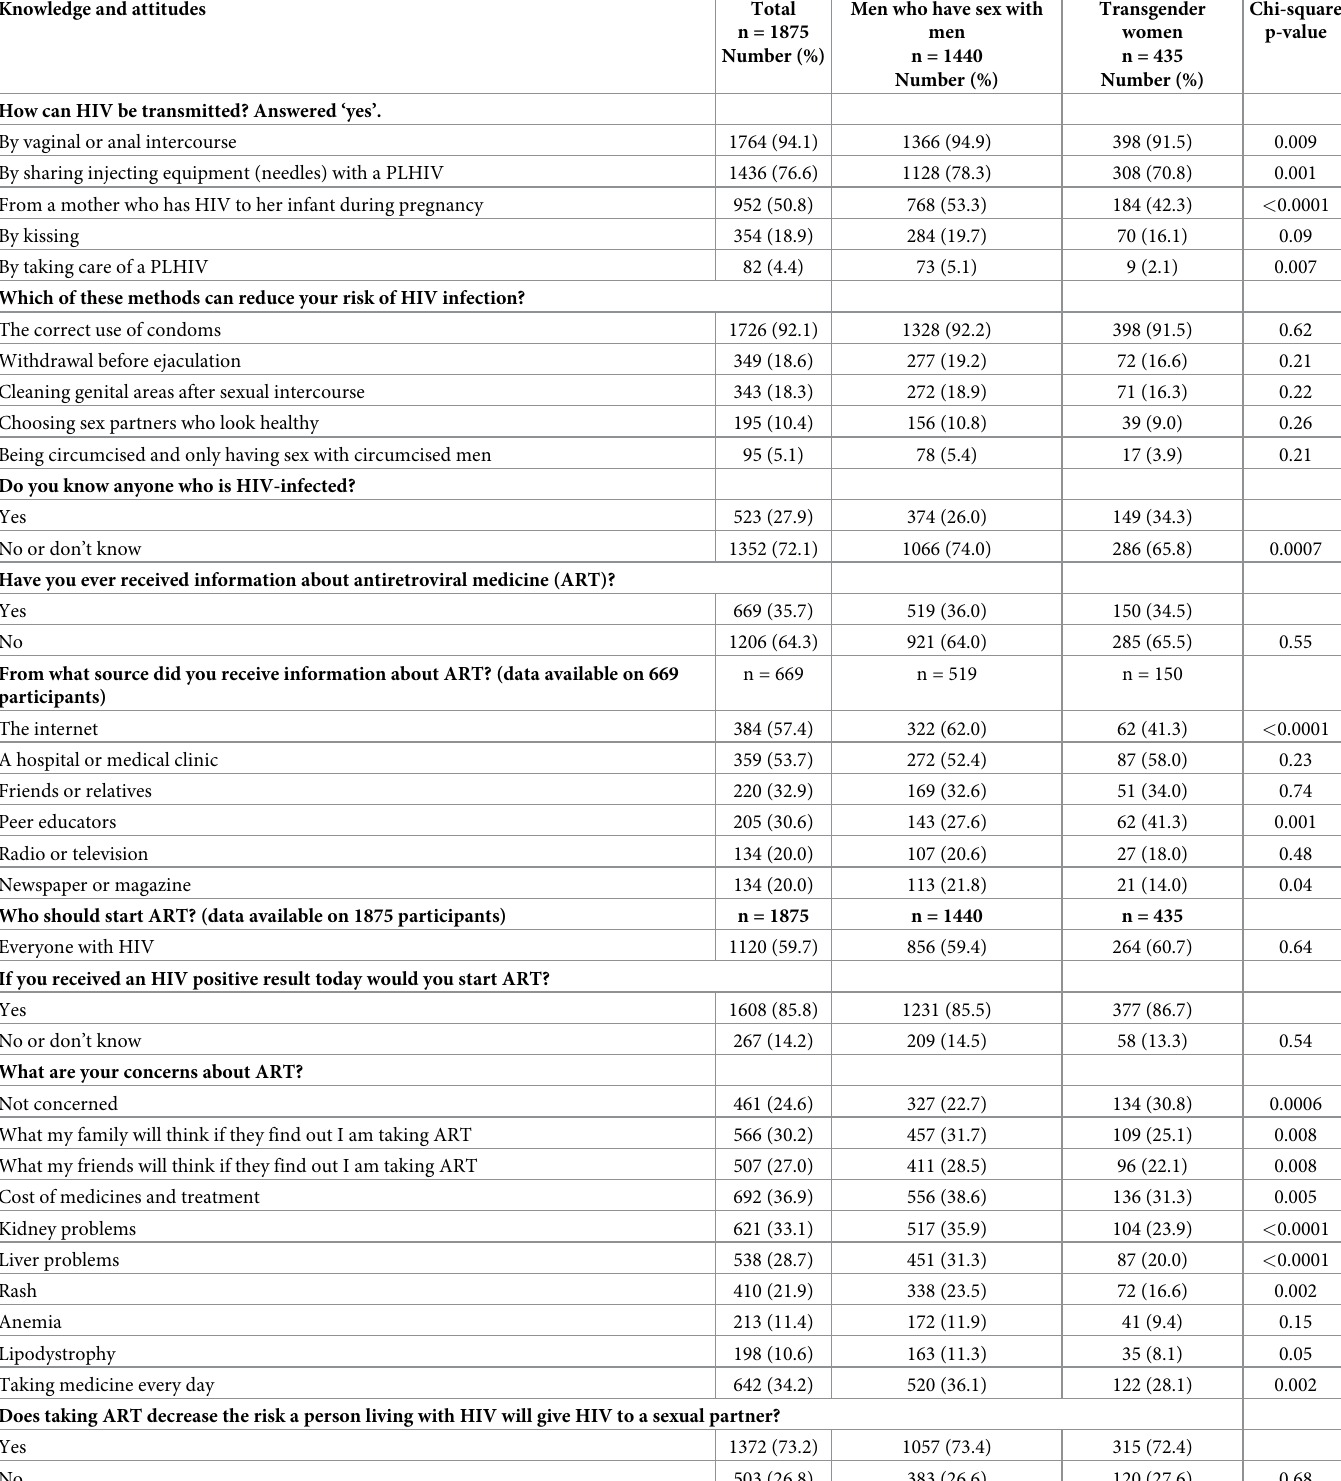
Table 2. Knowledge and attitudes of test, treat, and prevent HIV program participants about HIV infection, antiretrovirals, and pre-exposure prophylaxis, Thai- land,